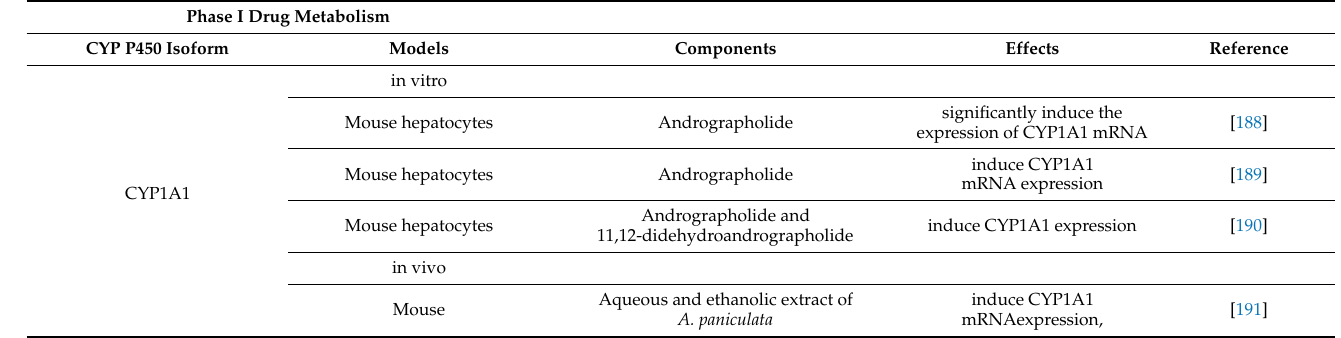
Table 3. The interaction of Andrographis paniculata with cytochrome P450 enzymes and the proteins associated with